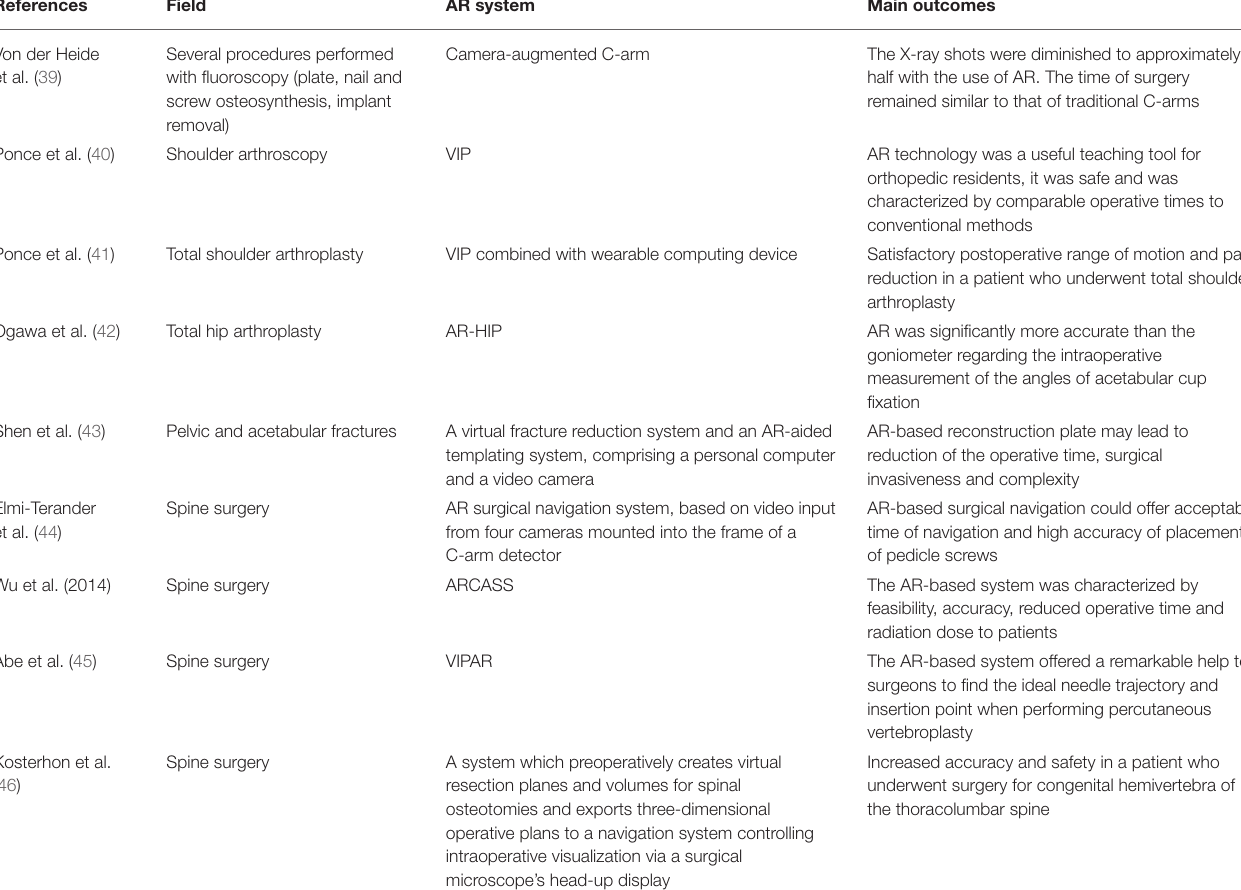
TABLE 1 | Clinical studies about augmented reality in